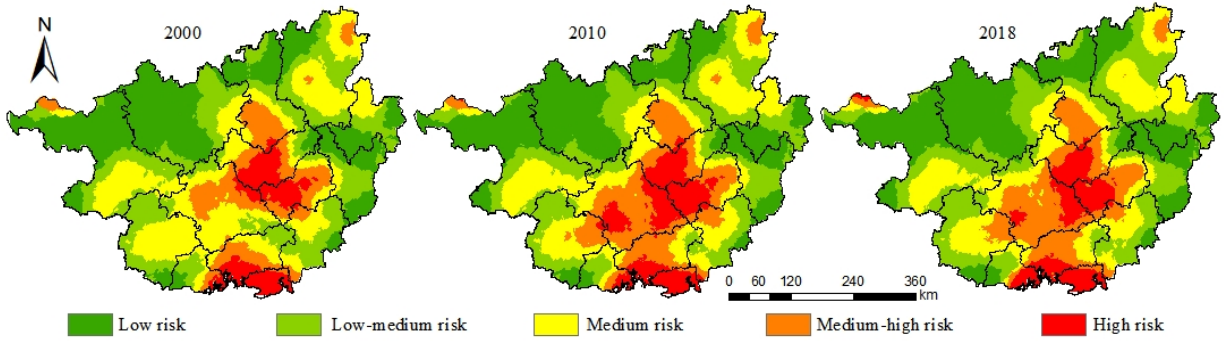
Figure 5. Spatial distribution of ecological risk levels in Guangxi.